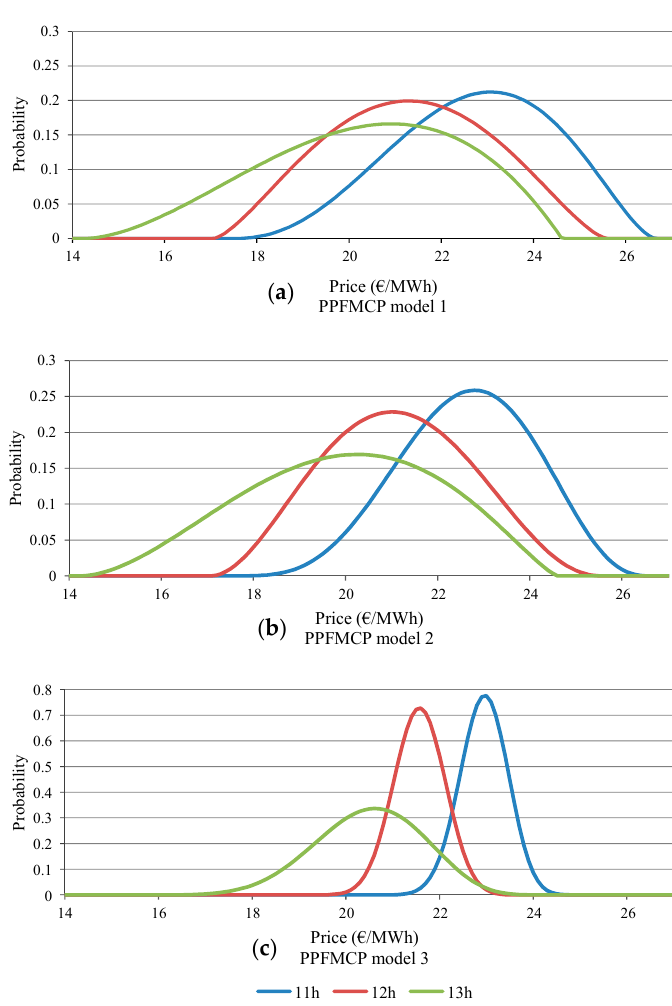
Figure 9. Probability density functions (PDFs) of the PPFMCP models for hours 11 h, 12 h, and 13 h on the 14th of April, 2016. ( a ) PPFMCP model 1; ( b ) PPFMCP model 2; ( c ) PPFMCP model 3.